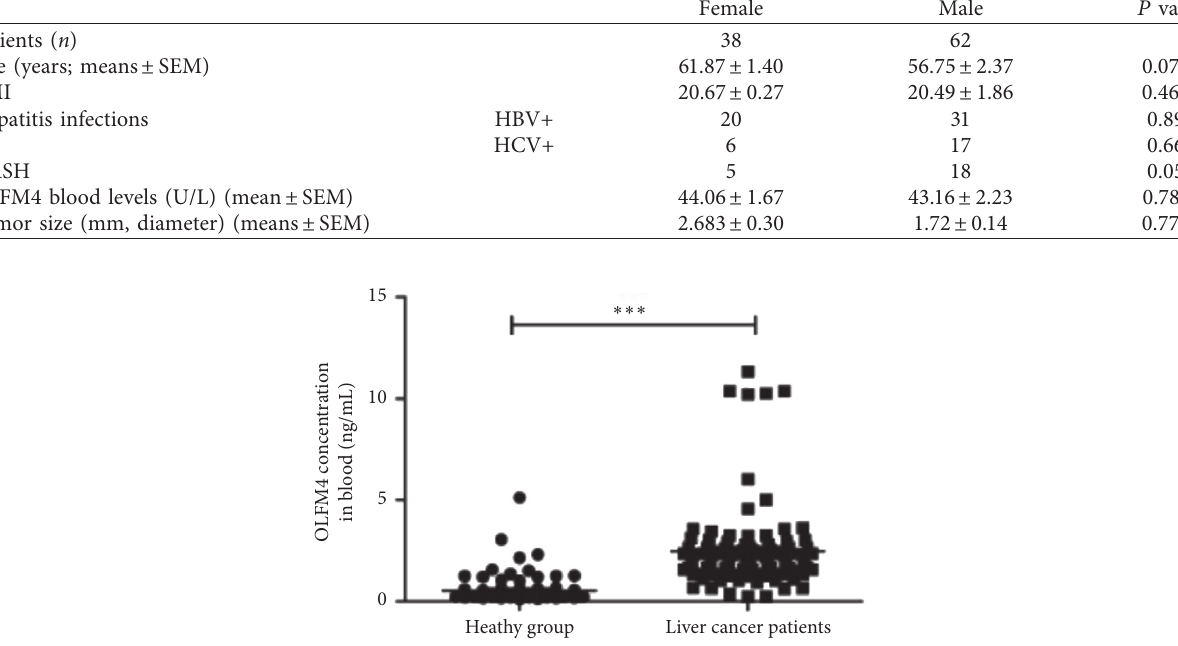
Figure 1: The blood level of OLFM4 in healthy individuals and HCC patients. ∗∗∗ P < 0 .